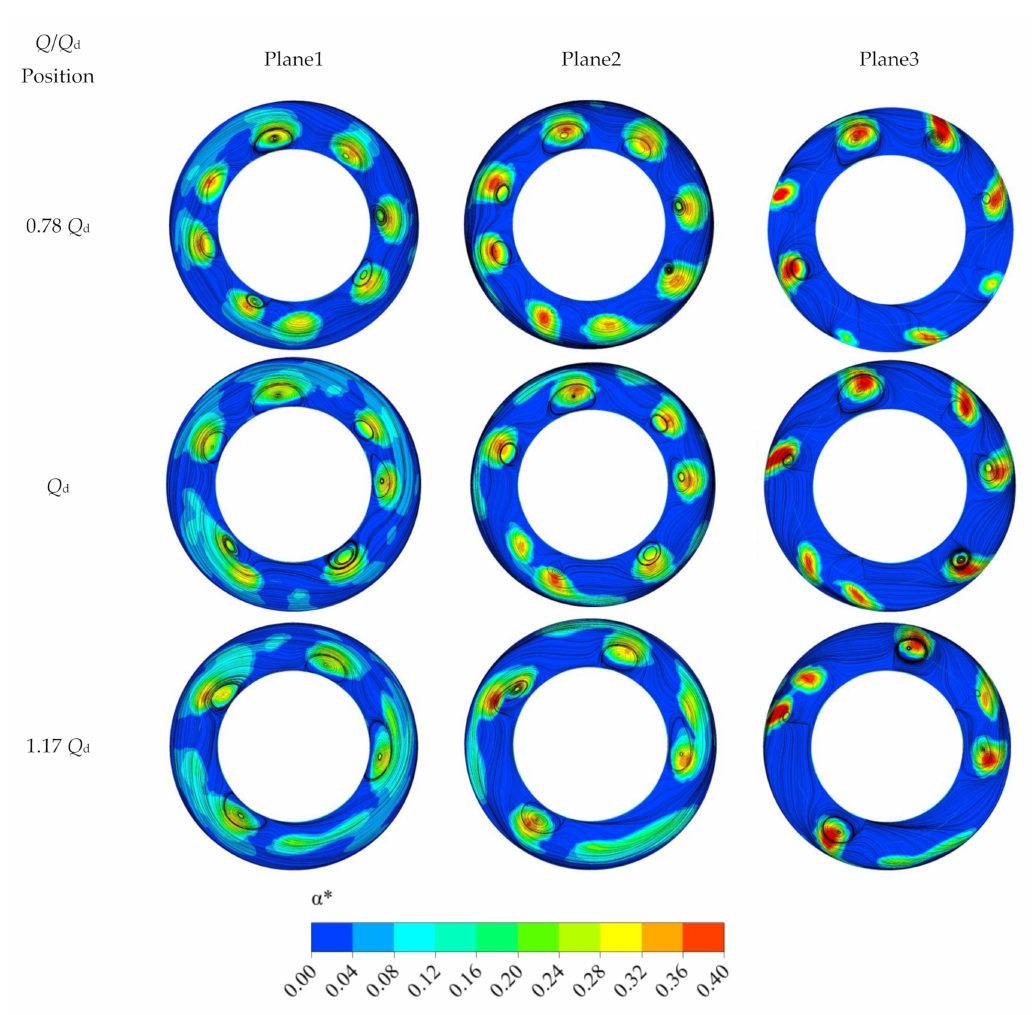
Figure 16. The eddy current intensity and streamline distribution of different